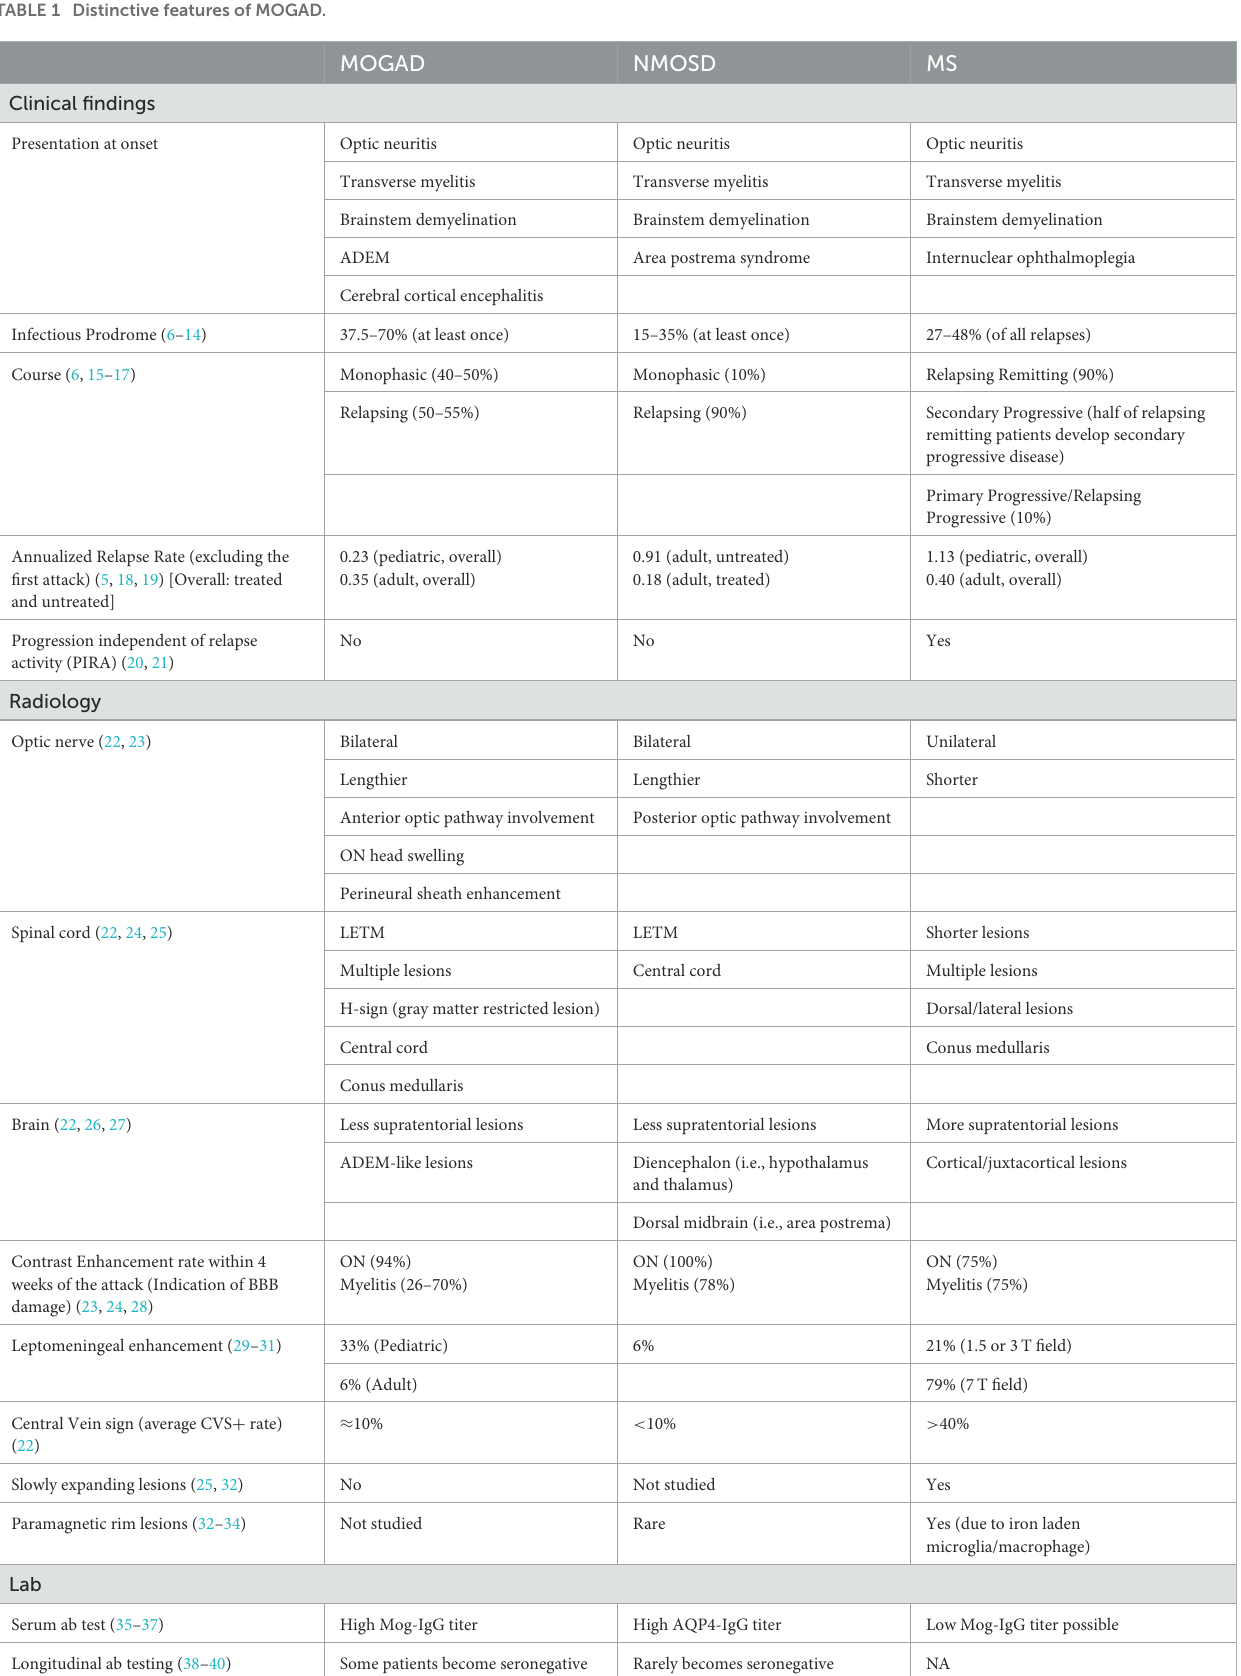
TABLE 1 Distinctive features of